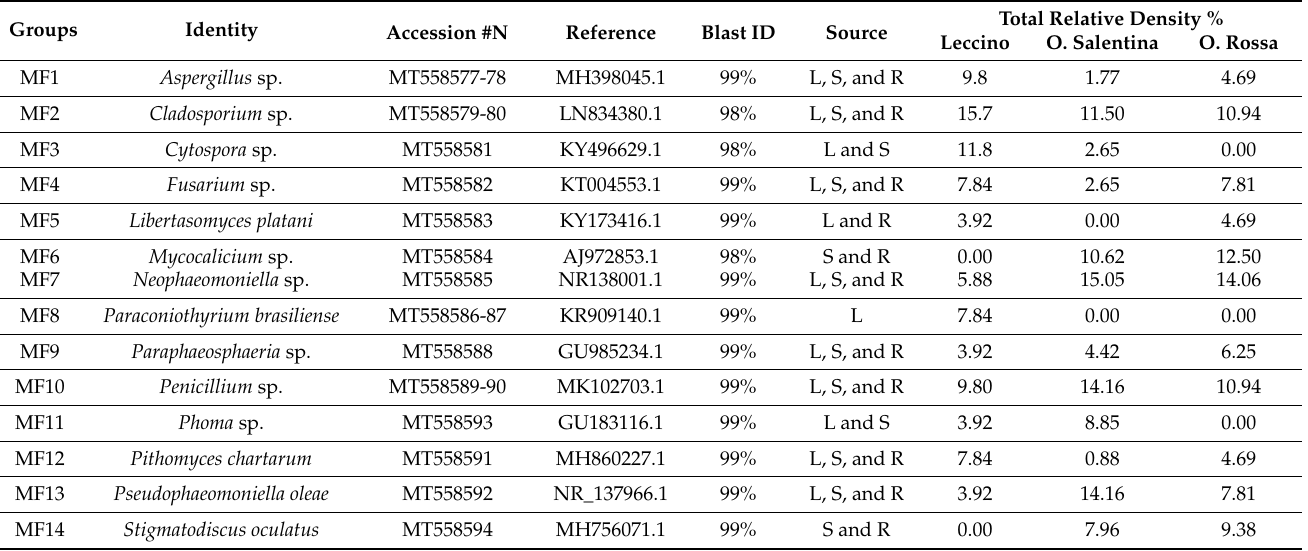
Table 2. Molecular characterization and relative density of fungal endophytes colonizing the twigs of different olive varieties in Apulia.